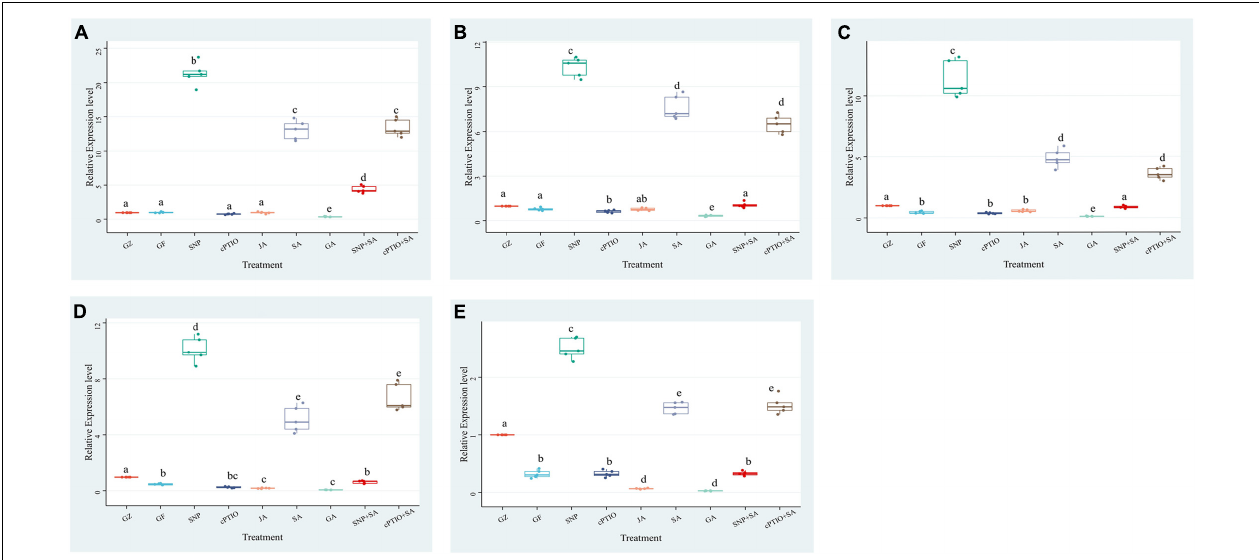
FIGURE 7 | Effect of NO effectors and/or phytohormones on expression levels of (A) psaL, (B) CHIL, (C) petF1, (D) psbQ, and (E) psaE , of T. hemsleyanum under photovoltaic condition (GF) and normal light condition (GZ). Data are means ± SE of the three technical replicates from five seedlings for each treatment. Means that do not share a same letter are significantly different at p ≤ 0.05 level through Tukey’s